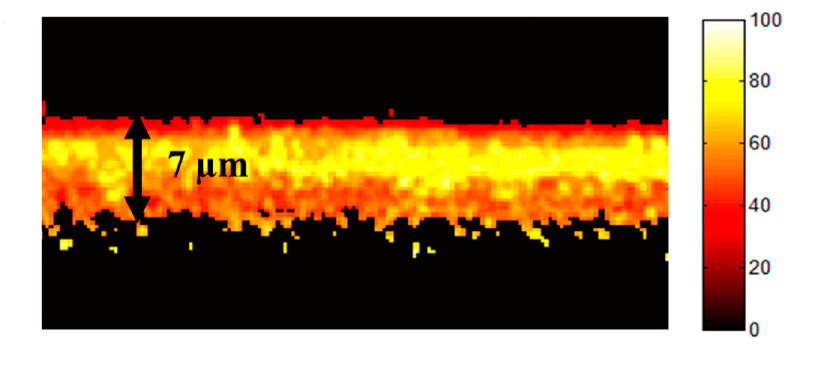
Figure 4. Confocal fluorescence microscopy image of a 7 µm tall CNT forest after functionalization with biotin-streptavidin